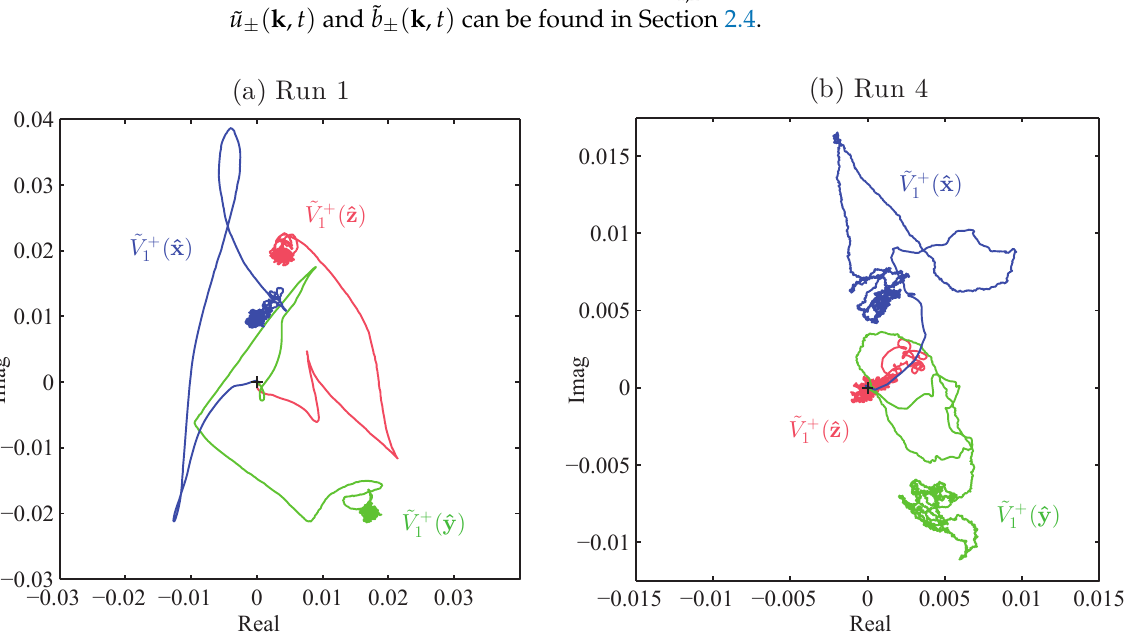
(ˆ k , t ) = ˜ u (ˆ k , t ), + 1